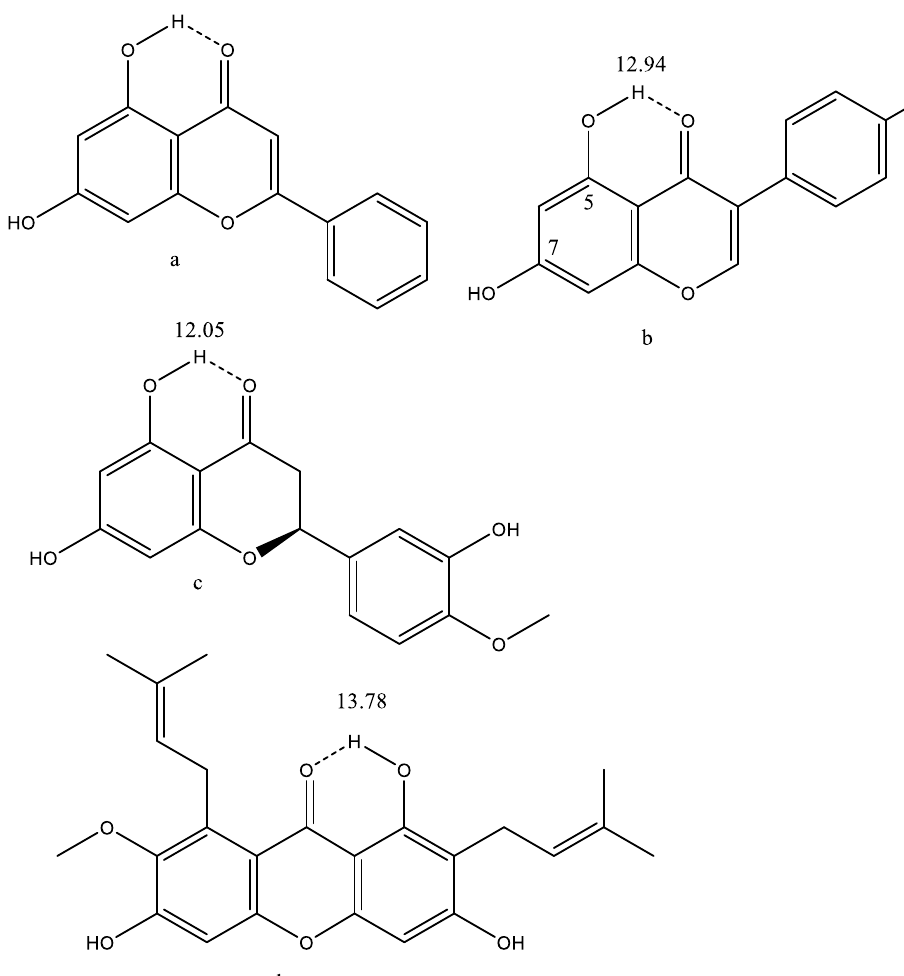
Figure 19. Flavonoids. Numbers are OH chemical shifts. ( a ). Chrysin. Data from Ref. [73]. ( b ). Genistein. From Ref. [74]. ( c ). Hesperetin. Data from the SDBS data base [75]. A number of other compounds are given in Ref. [76]. ( d ) . α -mangostin from Ref. [77].